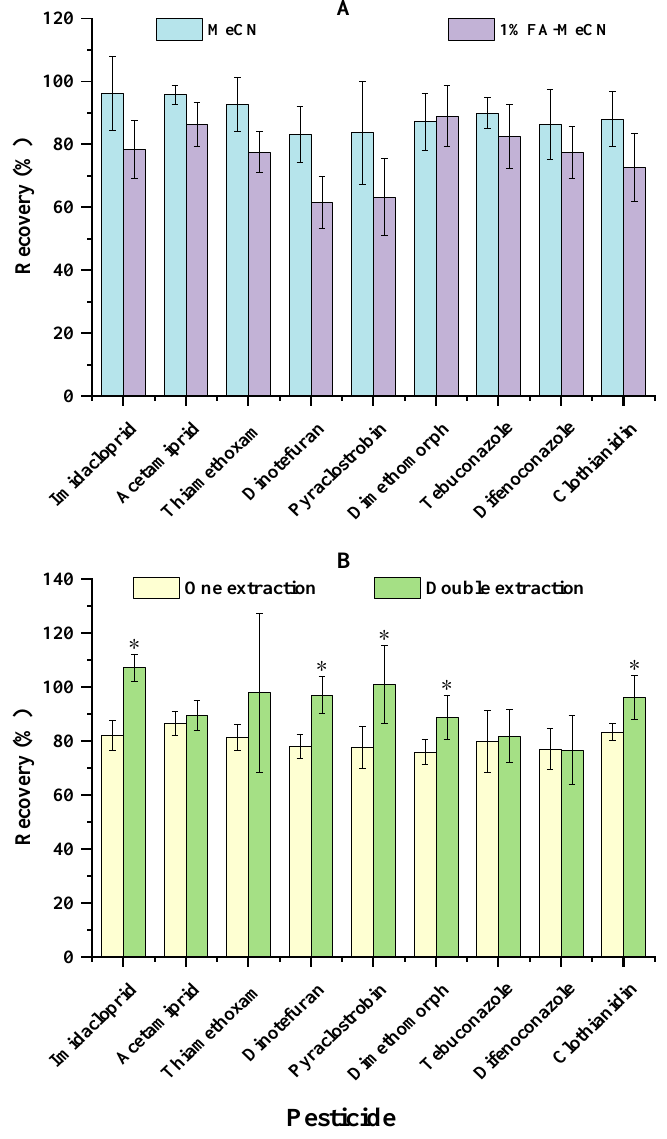
Figure 2. The recoveries of the LC-amenable pesticides with different extraction solvents ( A ) and times ( B ) (*presents p <